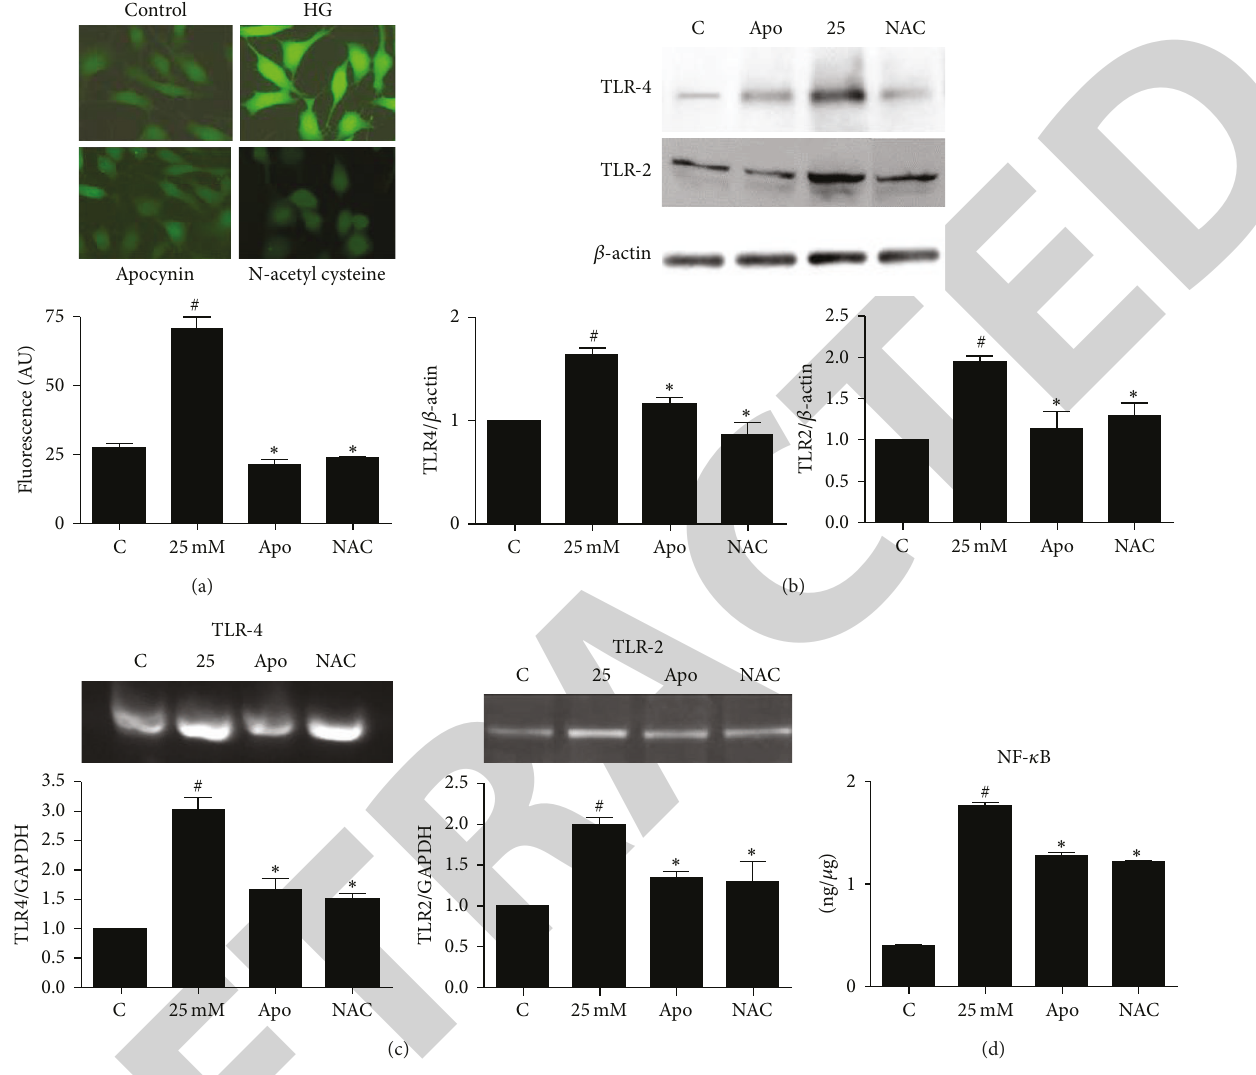
Figure 9: Antioxidant treatment attenuates HG-mediated ROS and TLR-2 and TLR-4 activation: HMVRECs treated with apocynin (60 𝜇 M) and N-acetyl cysteine (10mM) and subsequently exposed to high glucose. (a) ROS measurement by H 2 DCFDA staining. # 𝑃 < 0.001 versus control and ∗ 𝑃 < 0.001 versus 25 mM; (b) TLR-2 and TLR-4 protein levels measured using western blot. # 𝑃 < 0.01 versus control and ∗ 𝑃 < 0.01 versus 25 mM; (c) TLR-2 and TLR-4 mRNA expression measured by PCR. # 𝑃 < 0.01 versus control and # 𝑃 < 0.05 versus 25 mM. (d) NF- 𝜅 B p65 measurement by ELISA, # 𝑃 < 0.001 versus control and ∗ 𝑃 < 0.001 versus 25 mM.